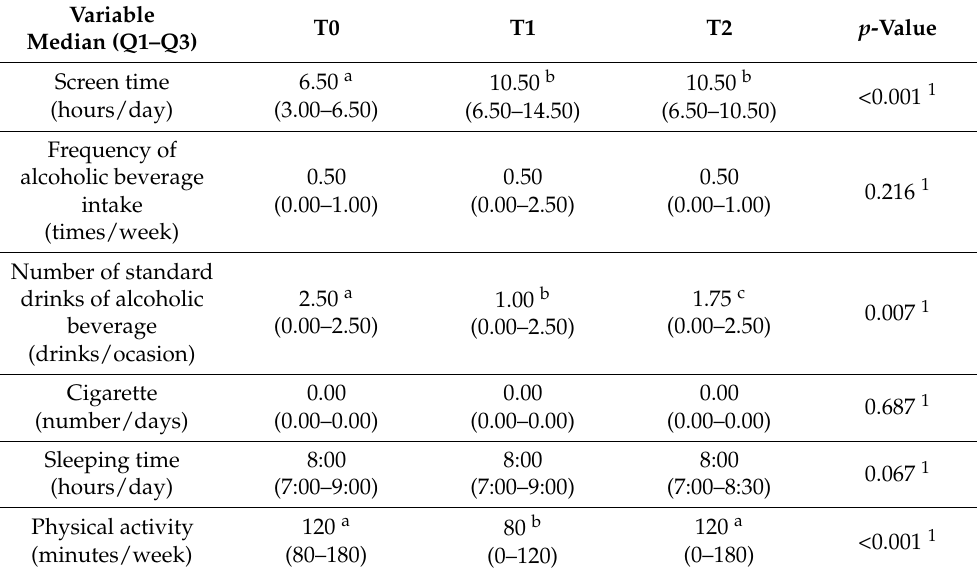
Table 2. Daily habits before and during the COVID-19